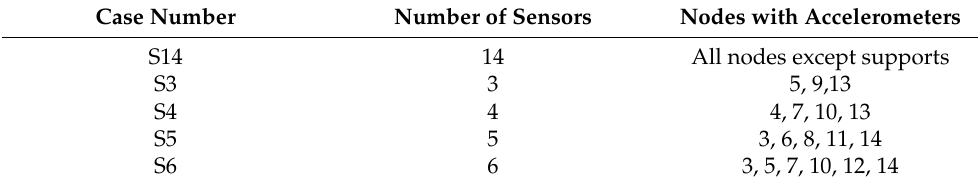
Table 5. Different sensor placements configuration.